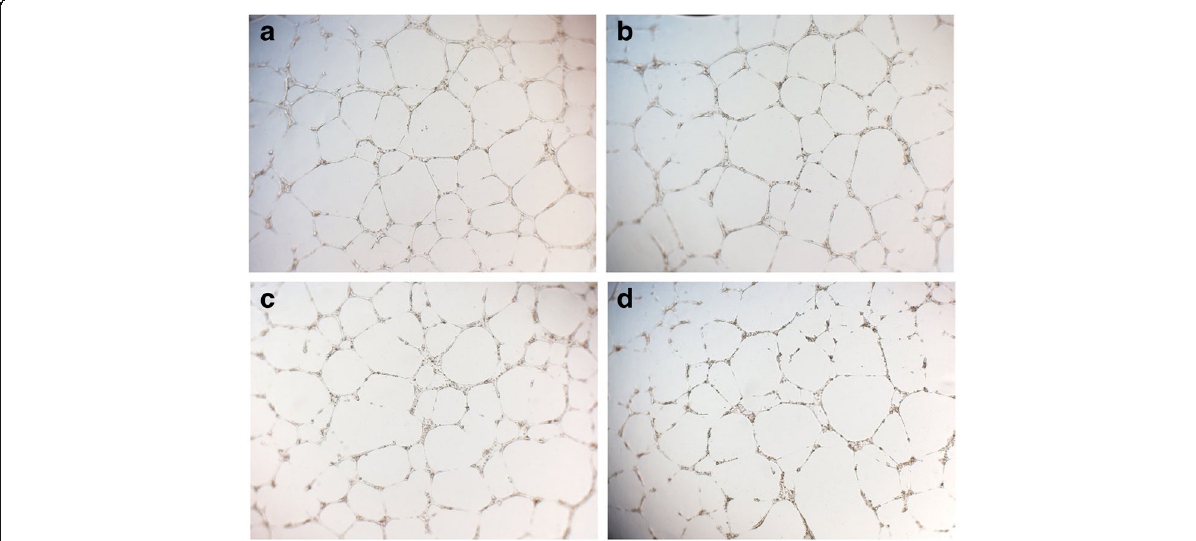
Fig. 7 Rhazya stricta extract inhibits tube formation in HUVECs on Matrigel in a dose-dependent manner. Photographs of tube formation in HUVECs on Matrigel after incubation with or without R. stricta extract at 18 h. Cells were treated with R. stricta extract at a series of concentrations (10 μ g; b , 20 μ g; c , 30 μ g; d ) or DMSO vehicle (control; a ) for 18